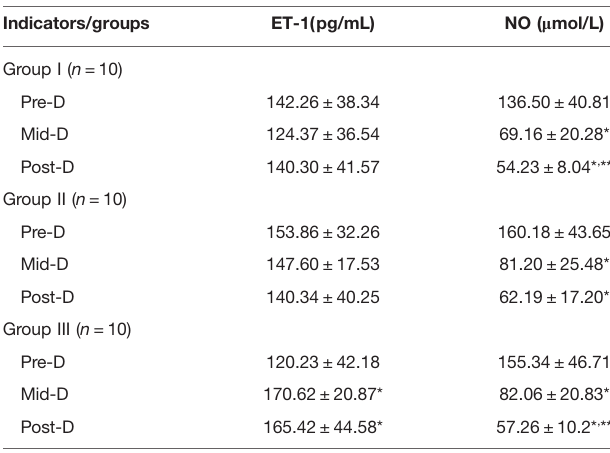
TABLE 2 | Comparison of serum NO and ET-1 levels at Pre-D, Mid-D and Post-D in group I, group II and group III (Mean, SD).